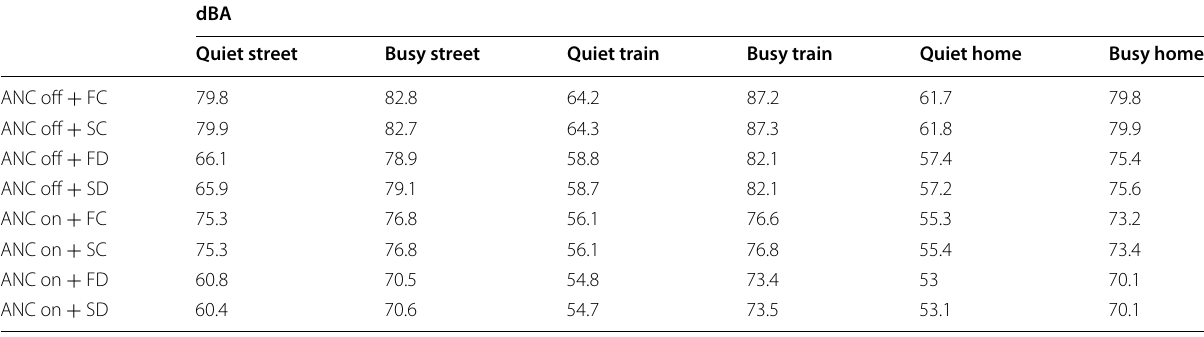
Table 2 Average SPL (in dBA) measurements of the VSE stimuli. The foreground element conditions are F - front position; S - side position; C - close and louder; D - distant and quieter